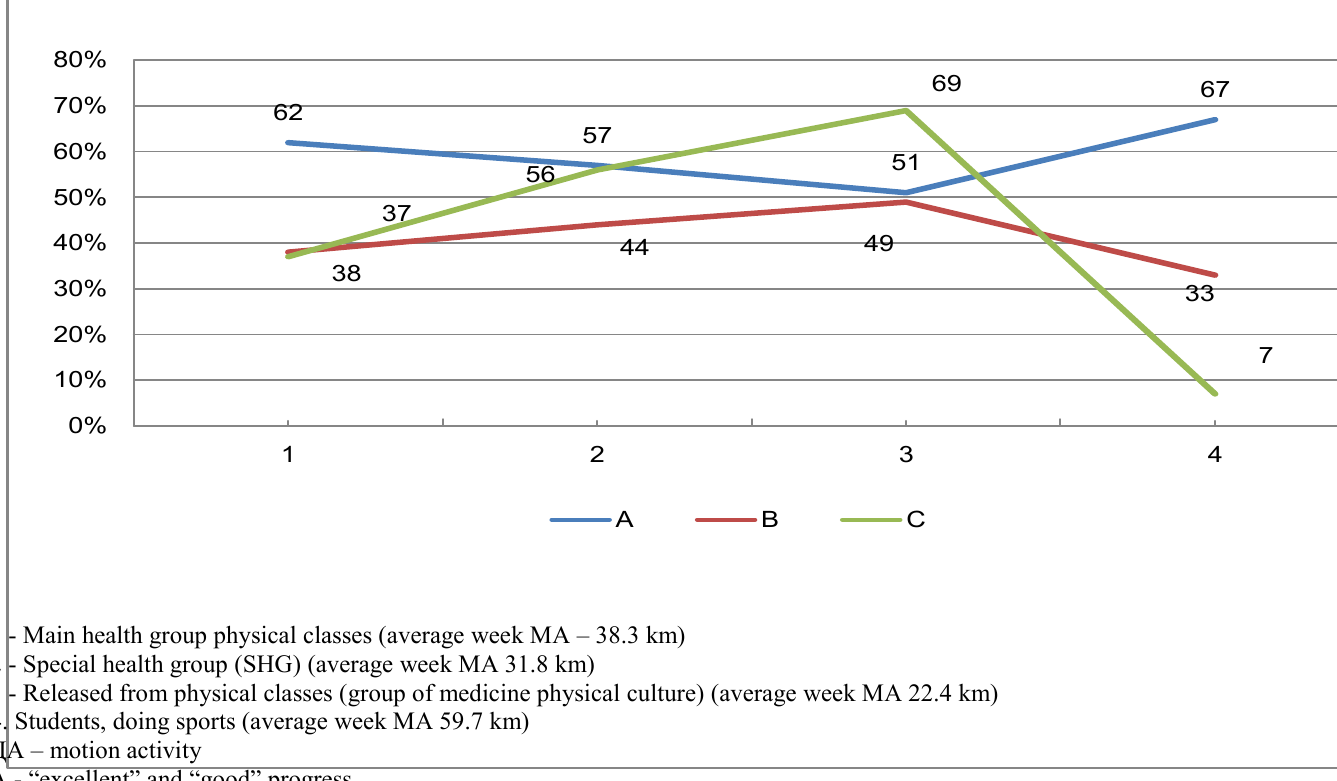
Fig. 5. The levels of progress and morbidity of students with different motion